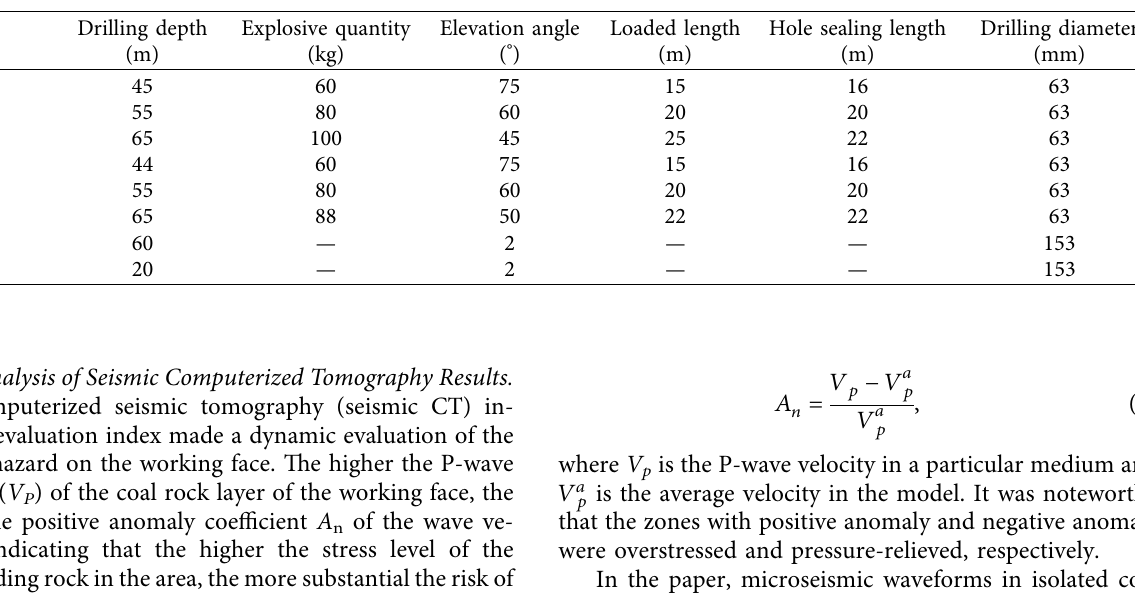
Table 5: Parameters of pressure relief measures for III-III